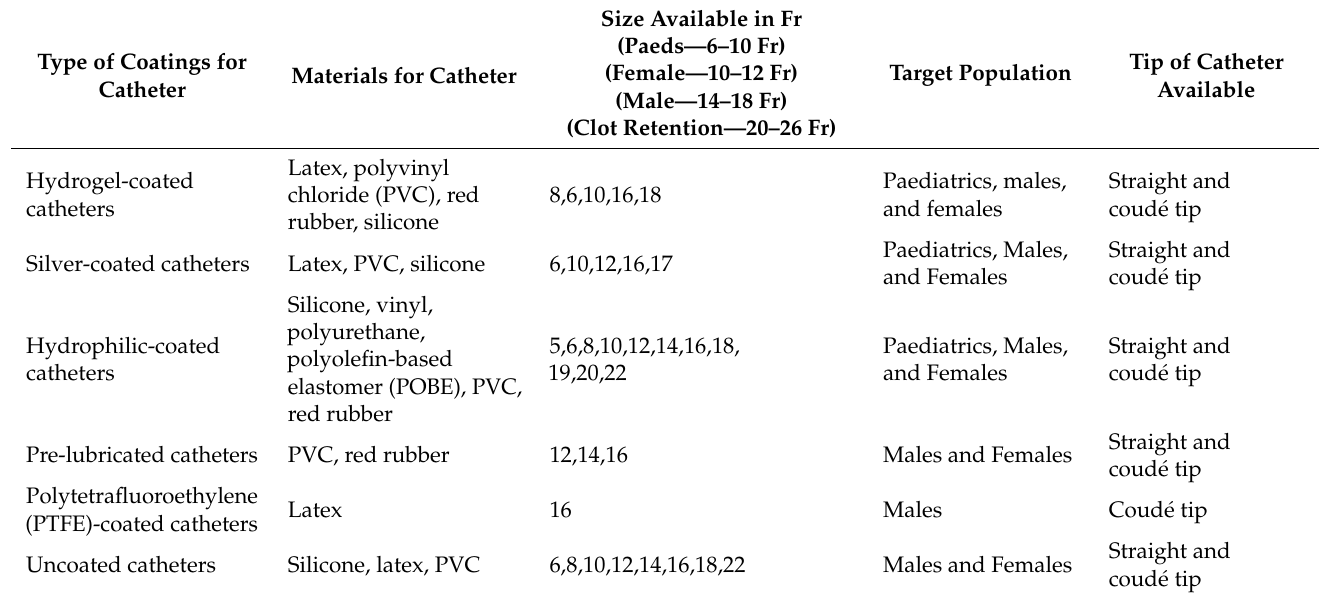
Table 1. Currently available catheter types in clinical use [20].